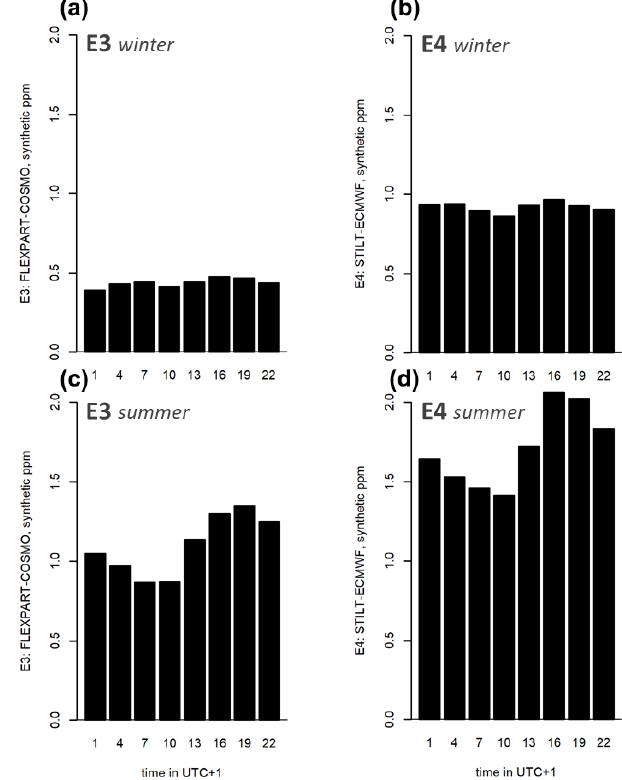
Figure A2. Mean diurnal PBL sensitivity (JFJ; winter, DJF, a, b and summer, JJA, c, d ) for the period 2009–2017 for (a) FLEXPART– COSMO (E3) and (b) STILT-ECMWF